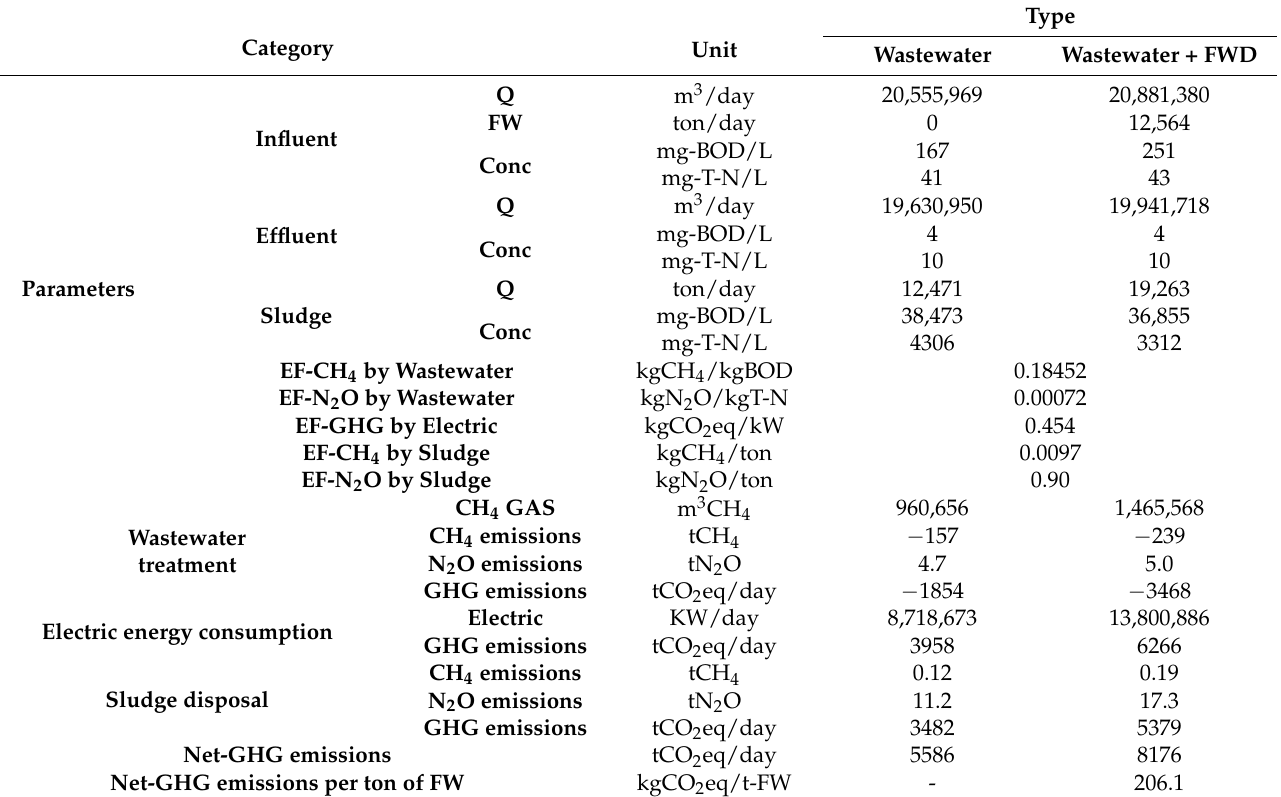
Table 4. GHG emissions from wastewater and wastewater + FWD treatment